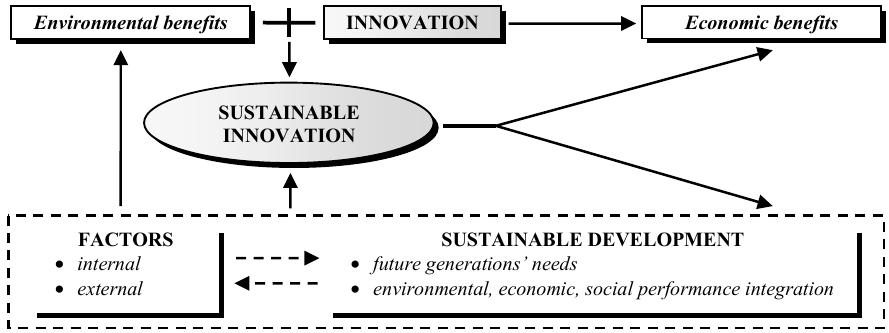
Figure 1. Conceptualization of sustainable innovation. Source: own study based on